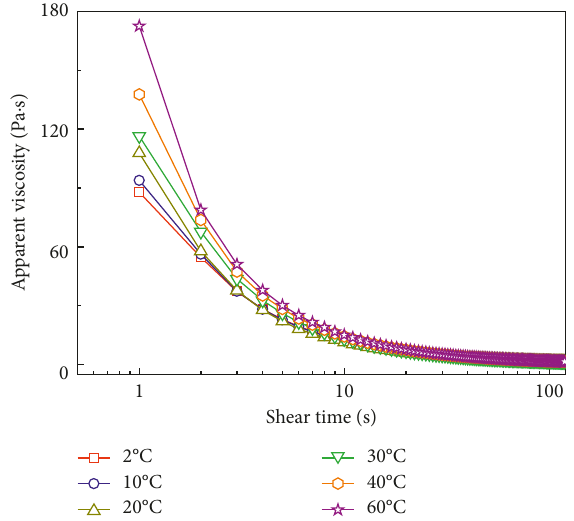
Figure 5: Apparent viscosity change as a function of shear time under different temperature conditions.